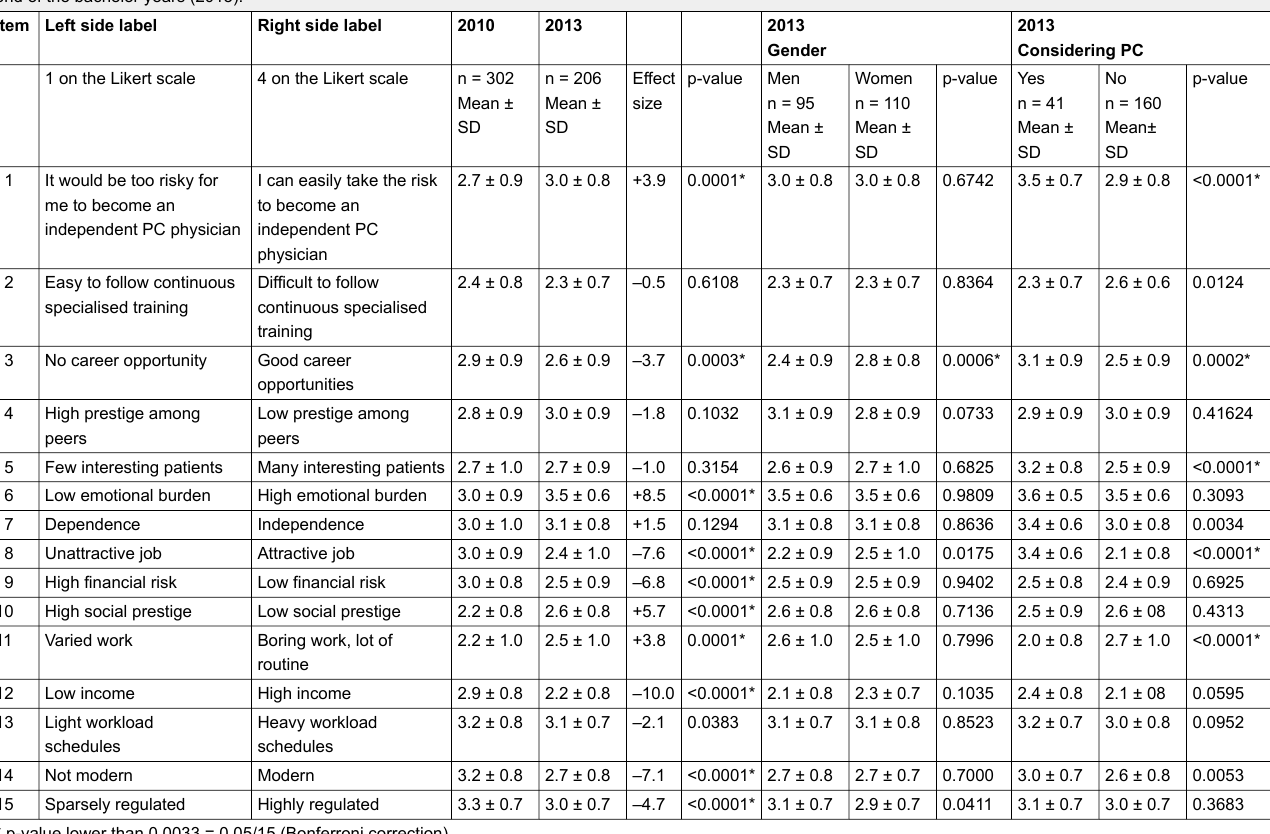
Table 1: Opinion (mean ± standard deviation) of the students regarding the occupation as primary care (PC) physician before starting the medical curriculum (2010), at the end of the bachelor years (2013). Item Left side label Right side